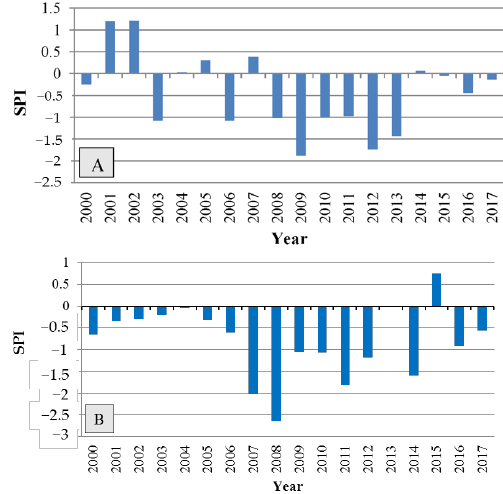
Figure 5. Standardized Precipitation Index (SPI) showing the severity and period of drought at the two sampling sites of Dareh‑shahr ( A ) and Ilam ( B